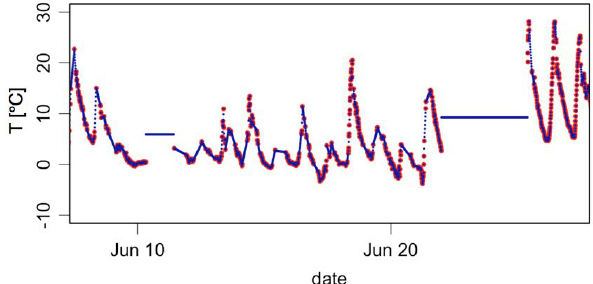
Fig. 6. Example of gap-filling with original values (red) and the resulting dataset after gap filling (blue). Note that the data in this graph (mh01; T 1 ) is a worst case concerning gap